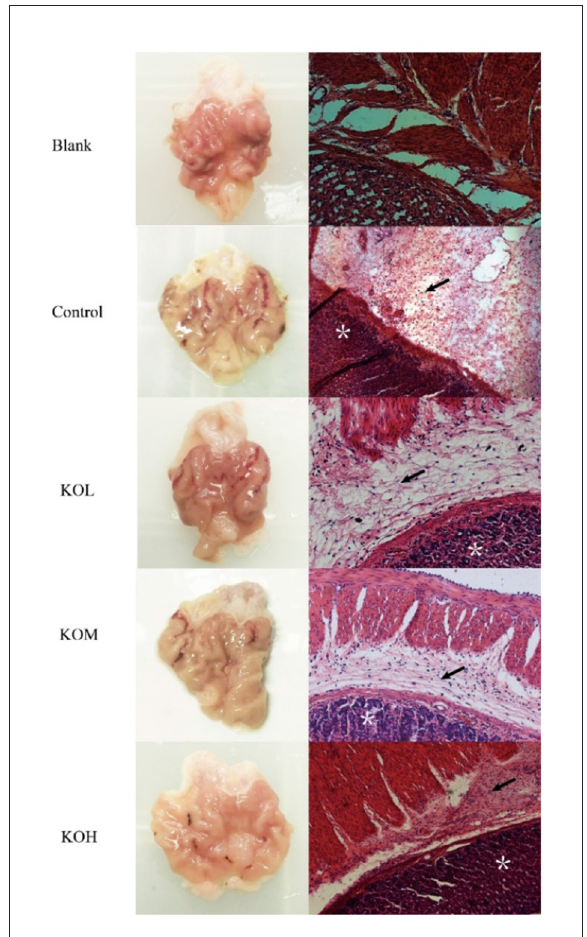
FIGURE2 Effect of KO on the morphology and pathological histology of sections of the gastric mucosa. H&E staining of muscularis mucosa, epithelia, and lamina propria ( × 200) showed that the control section was severely injured, with extensive hemorrhage and necrosis in local areas, the necrosis and shedding of cells in the lamina propria of the mucosa, extensive inflammatory cell infiltration, and rupture and shedding of cells in the mucosal muscle layer. Following pre-treatment with different doses of KO, the damage of gastric mucosa was reduced in a dose-dependent manner. Arrows indicate the edema of submucosa and inflammatory infiltration. *Depicts damaged mucosal epithelium with disrupted glandular structure.